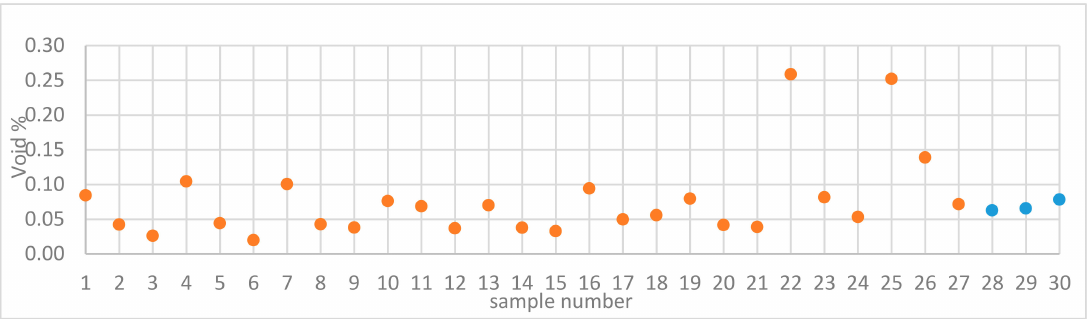
Figure 2. Void contents of samples manufactured by L-PBF (samples with varied parameters are in orange color, while replicates are in